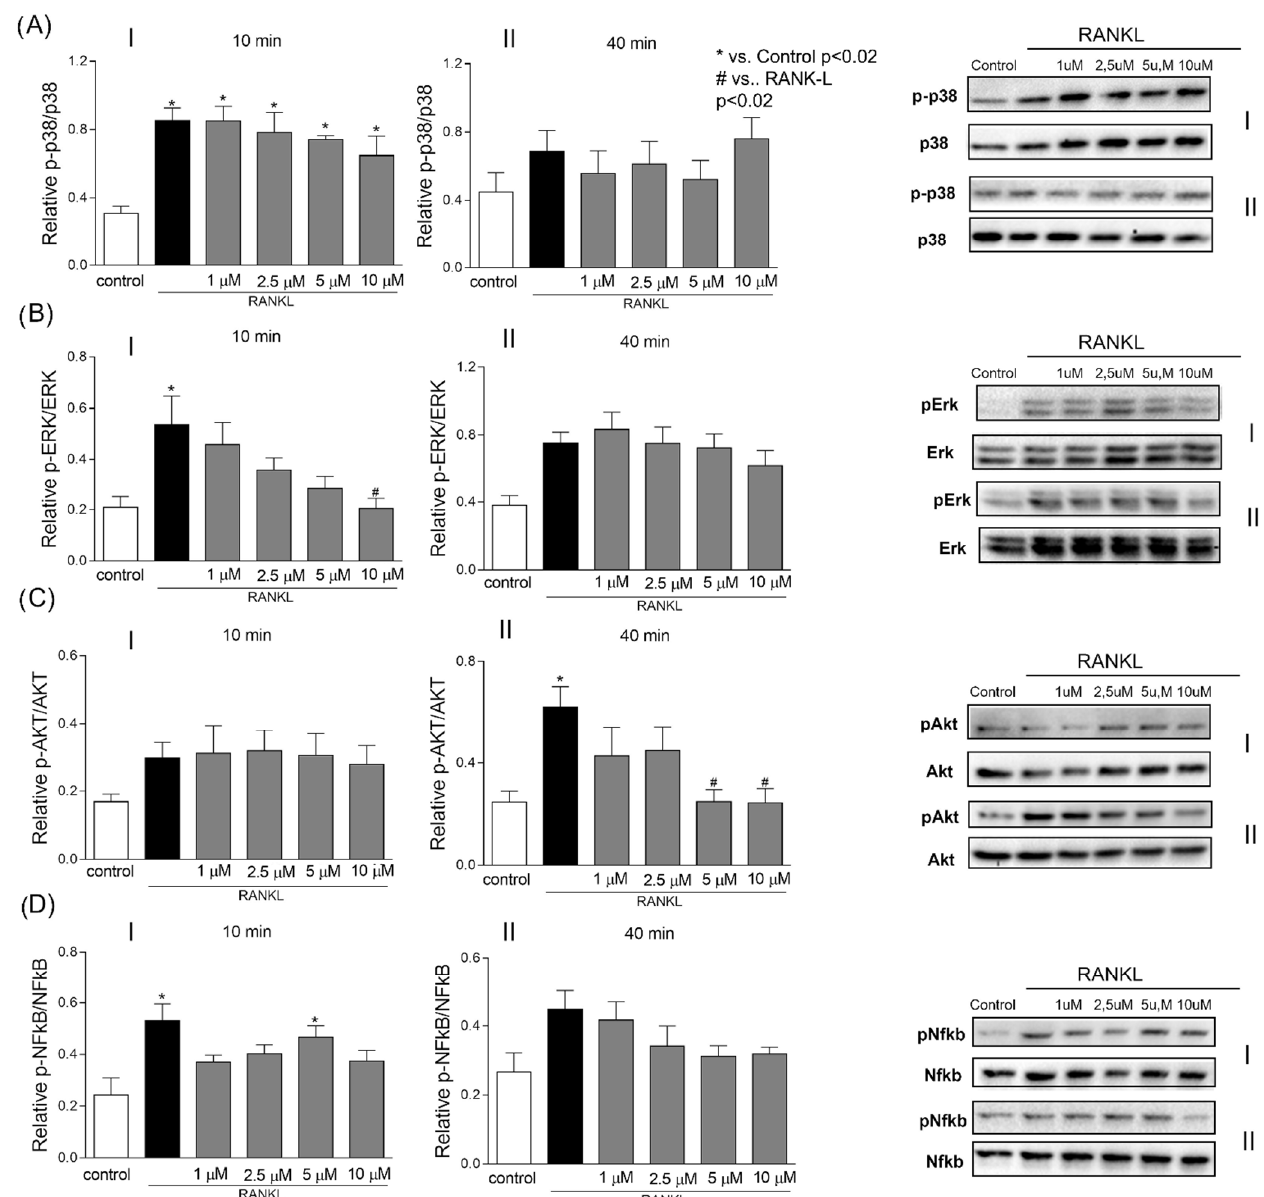
Figure 4. Chalcone T4 inhibits ERK and AKT activation. The graphs depict the mean and standard deviations of the densitometric analysis for the bands corresponding to ERK ( A ), AKT ( B ), p-38 ( C ) and NF-KB ( D ), after 10 ( I ) or 40 min ( II ) of stimulation with RANKL. Chalcone T4 suppressed ERK and AKT activation after 10 and 40 min, respectively, of stimulation with RANKL. Bars indicate mean results and vertical lines the standard error (SEM) of three duplicate experiments. p values are presented in the fi gure.